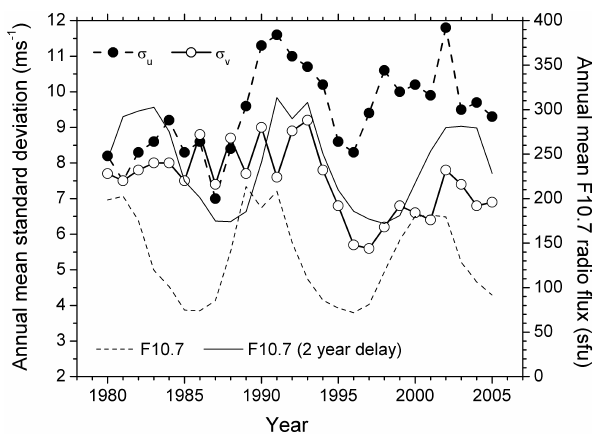
Fig. 6. Time series of annual mean σ u and σ v in the period range 2– 7 days, together with the annual mean F10.7 solar radio flux (dashed line). The solar flux, which was shifted by 2 years and 100sfu is also added as solid